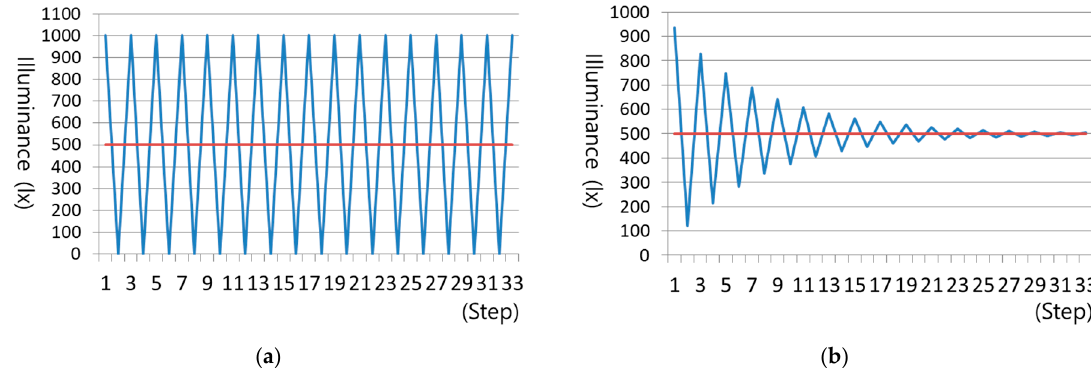
Figure 5. Maintaining the target illuminance of the DRDS with application of simple commissioning: ( a ) convergence case; ( b ) divergence case.